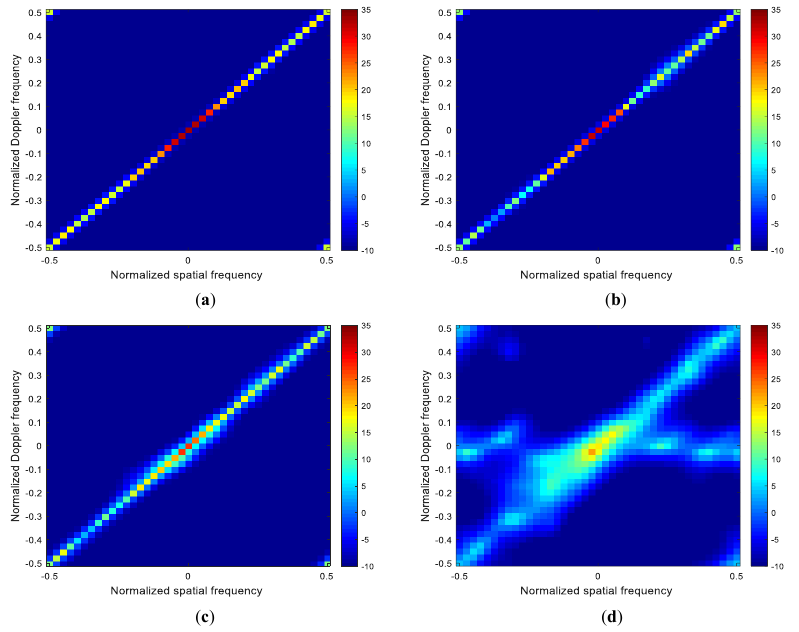
Figure 12. Clutter capon spectra of different methods. ( a ) OPT-STAP; ( b ) MESV-MSBL; ( c ) SESV- MSBL; ( d )